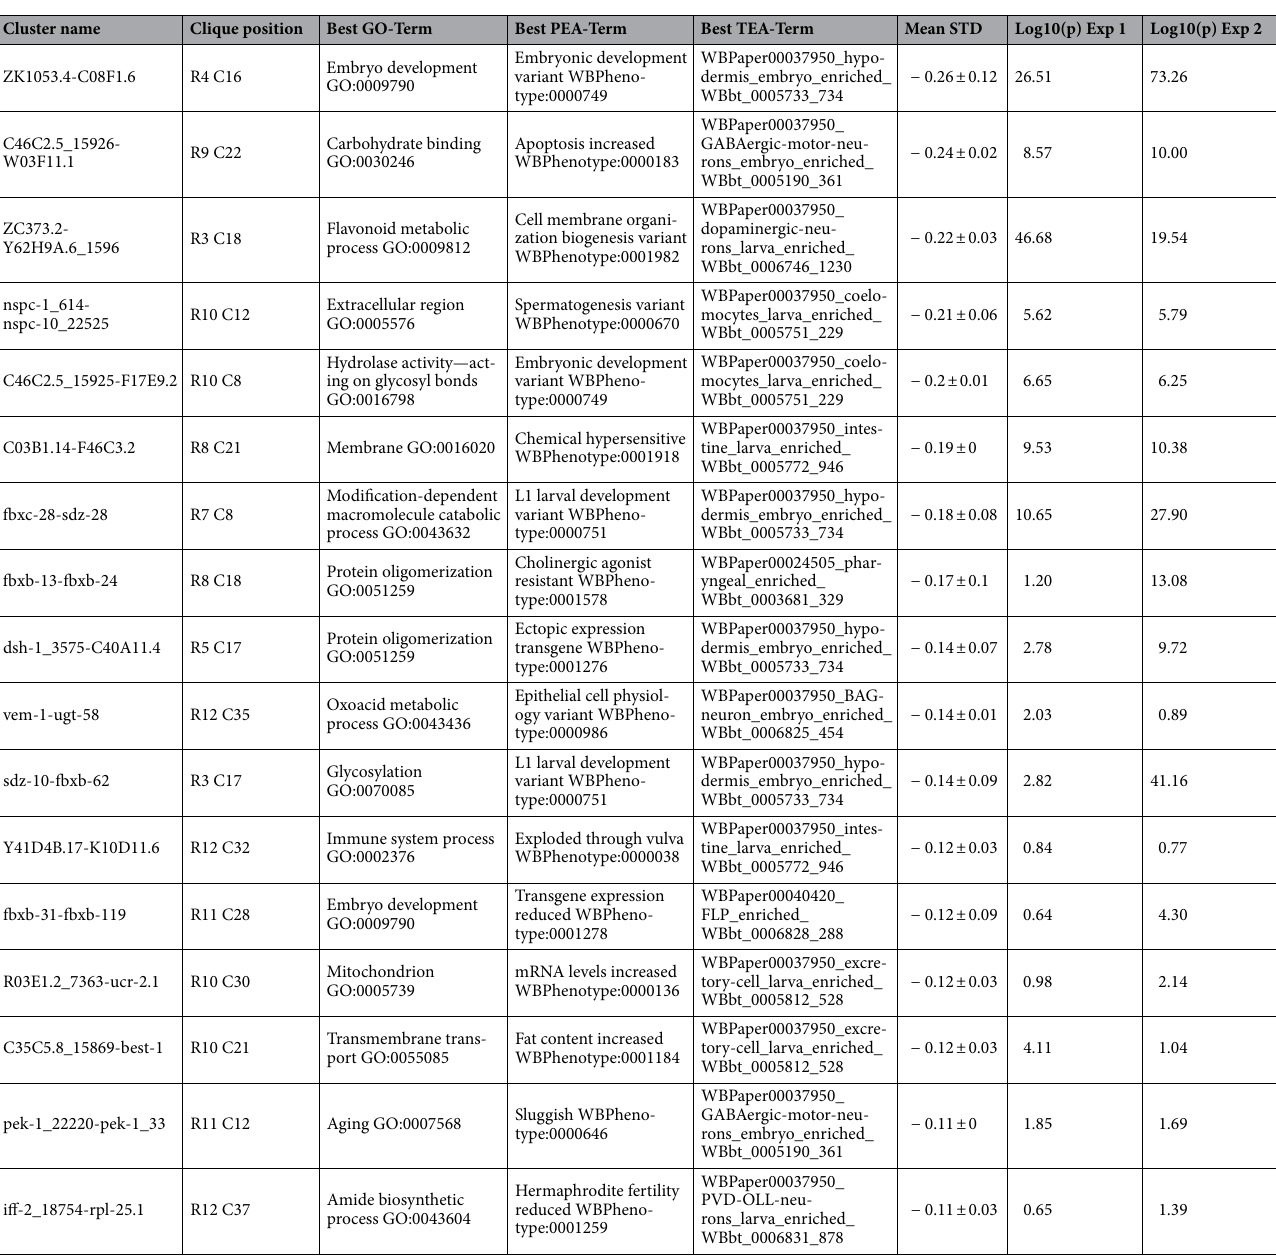
Table 3. Most strongly affected cliques by unc-45 RNAi and their characteristics. Clique positions (letter = row, number = position from left to right) correspond to the clique map shown in Fig.